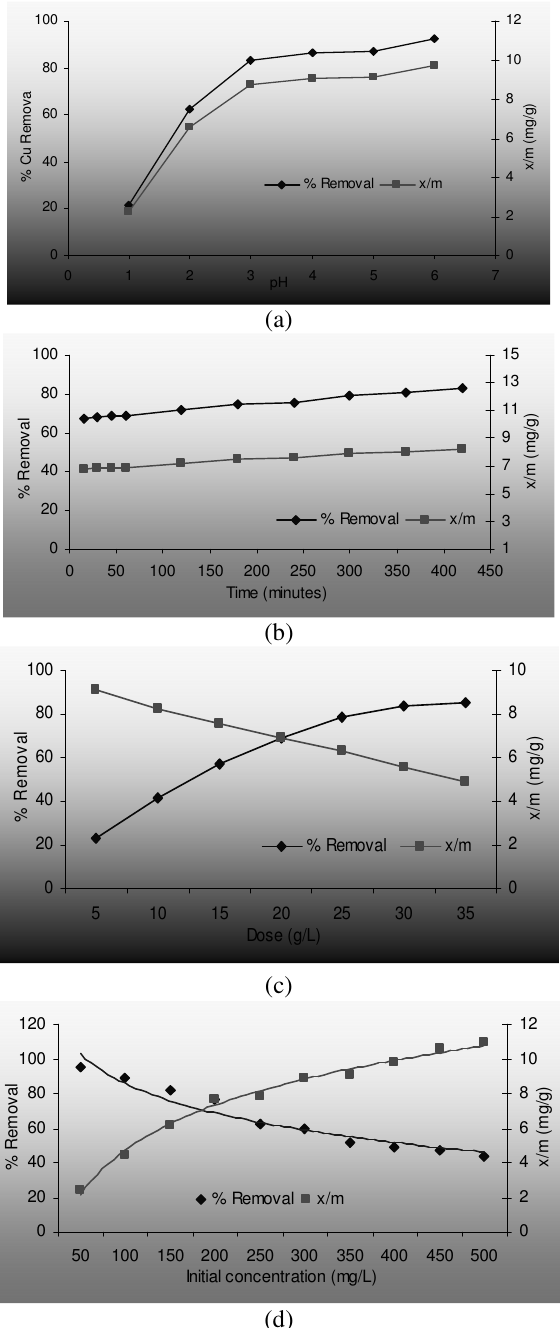
Figure 5. Effect of (a) pH, (b) shaking time, (c) sorbent dose, and (d) sorbate concentration on sorption of Cu +2 on